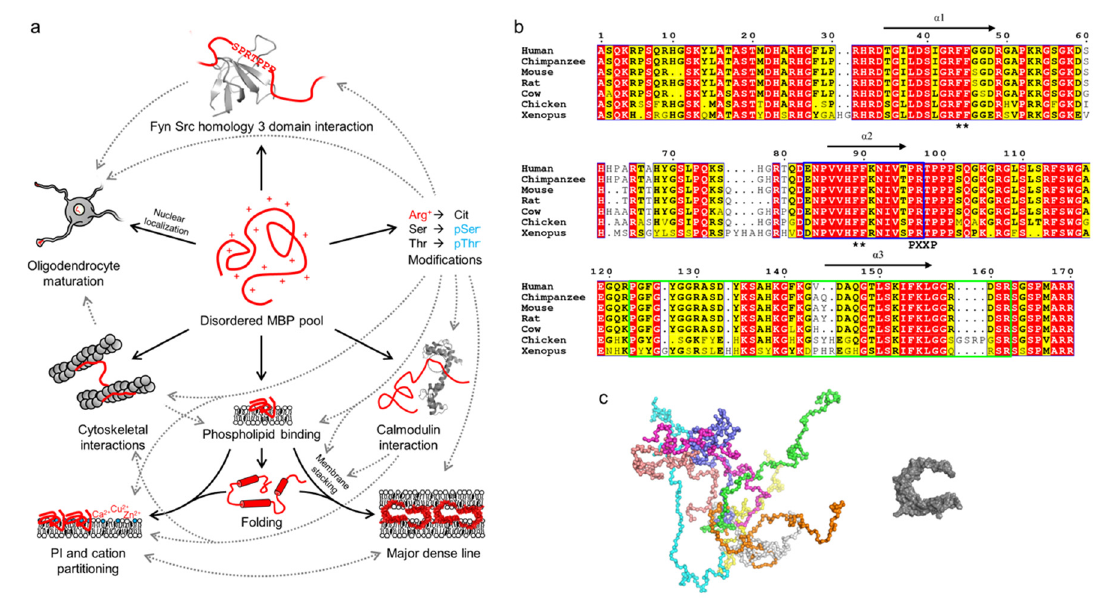
Figure 3. The multifunctionality, conformations, and conservation of MBP. ( a ) Schematic of the multifunctionality (solid arrows) of MBP, which arises through its disordered nature. Various PTMs, especially citrullination and phosphorylation, regulate the known functions of MBP (dashed arrows). The panel was inspired by Vassall et al. [65]. ( b ) Sequence alignment of 18.5-kDa MBP from vertebrates generated using ESPript [66]. MBP is highly conserved, especially all helically folding, lipid-interacting segments (black arrows; α 1- α 3), one of which overlaps with the immunogenic region (blue outlines). A noteworthy feature is the conservation of Arg residues, most of which are targets for citrullination. Black asterisks denote double-Phe motifs that are required for the phase transition of MBP upon lipid binding. Residue numbering corresponds to human MBP. ( c ) Conformational ensemble of 18.5-kDa MBP as determined using SAXS [24] (left) in comparison to a model of lipid-bound MBP [67] (right). Each colored chain in the ensemble represents a single conformational subpopulation in the pool of disordered MBP.